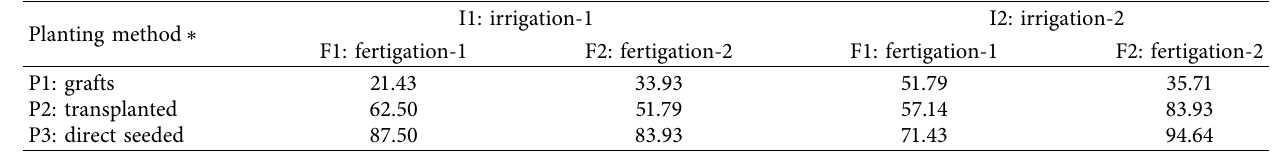
Figure 5: Incidence of bacterial wilt in tomato grafts on S. torvum (Expt. 1 and 2); on Surya and S0004 (Experiment 3) and nongrafted seedlings in the greenhouse evaluation. Two-sample T -test analysis indicated that wilt incidence in grafts is significantly less ( p < 0 . 05) compared to wilt incidence in the nongrafted seedlings in all the three experiments. Mean wilt incidence in grafts is significantly less compared to wilt incidence in nongrafted seedlings at 5% level (LSD � 8.696 for experiments 1 and 2, 3.835 for experiment 3). Bar in the column represents the standard error. Wilt % in the column indicated by the same letter are not significantly different at 5% level. Table 2: Incidence of bacterial wilt in tomato (GS-600) grafts and nongrafted seedlings planted with two drip irrigation levels and two fertigation levels in polyhouse (2017–18; 6